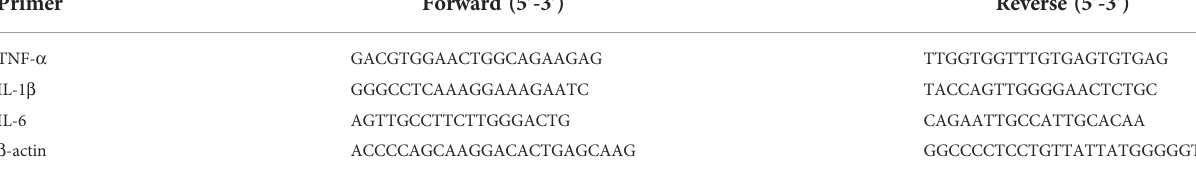
TABLE 1 Sequences for RT-PCR